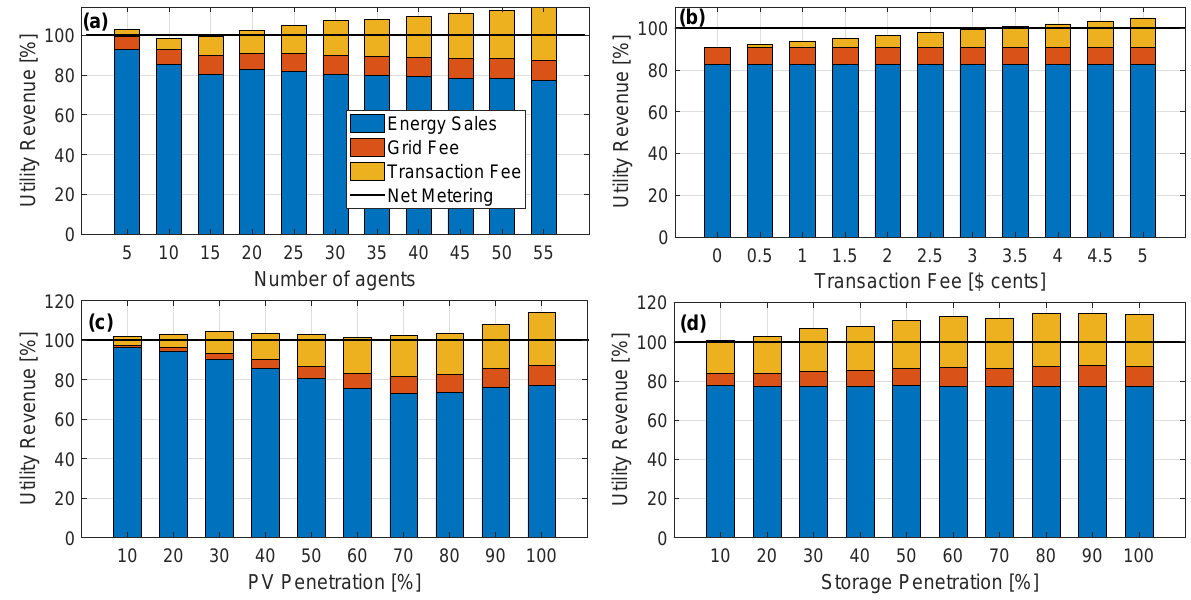
Figure 9. Utility revenue variation (in the percentage of the revenue in net-metering scenario) as a func- tion of ( a ) number of participating agents; ( b ) transaction fee; ( c ) PV penetration; ( d ) storage